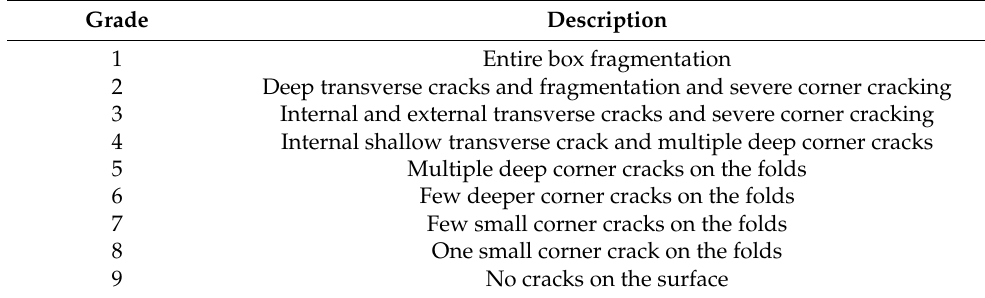
Table 2. Crushing performance rating system.